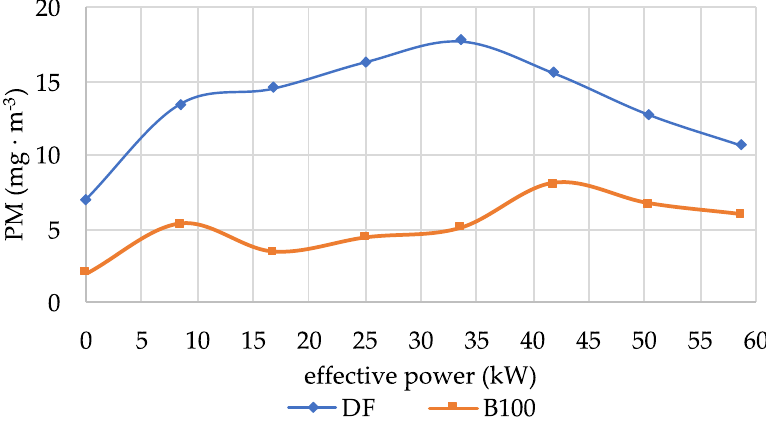
Figure 7. PM emissions vs. the effective power of the John Deere 4045TF285JD engine at 1650 rpm.